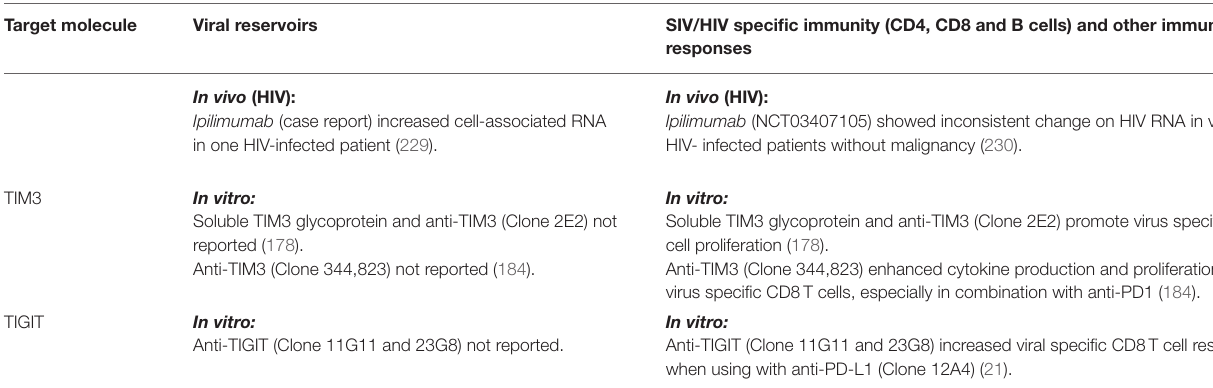
Target molecule Viral reservoirs